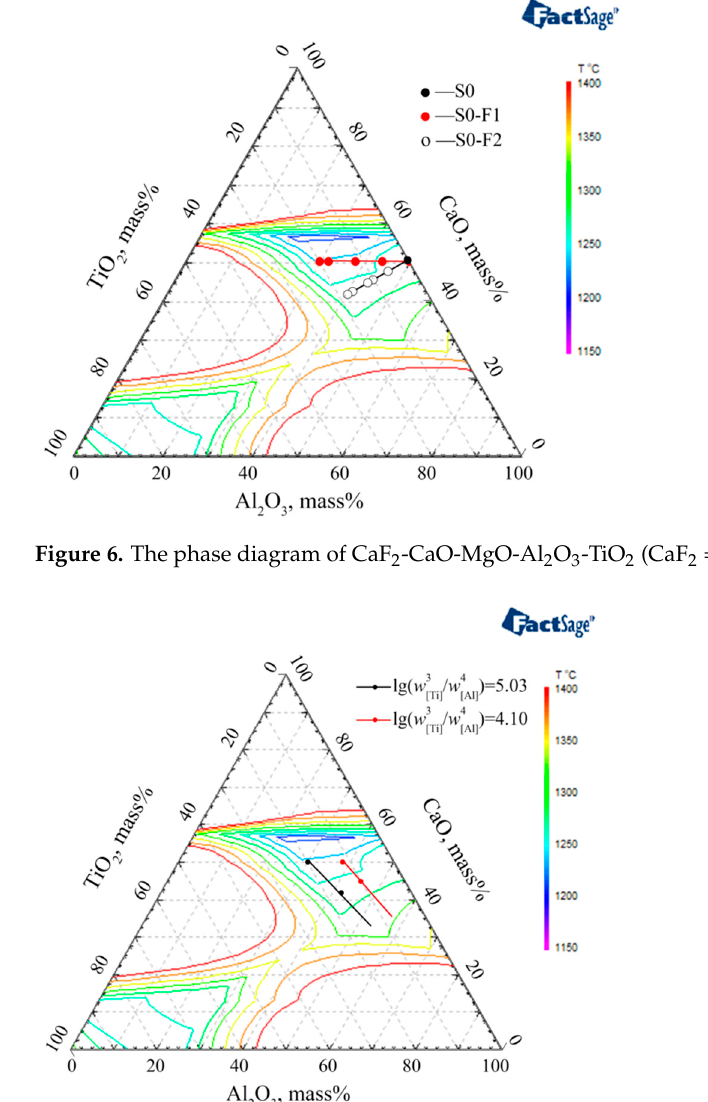
Figure 7. The phase diagram of melting temperature and isoactivity lines of lg ( a 3 CaF 2 -CaO-MgO-Al 2 O 3 -TiO 2 (CaF 2 = 46% and MgO = 4%).